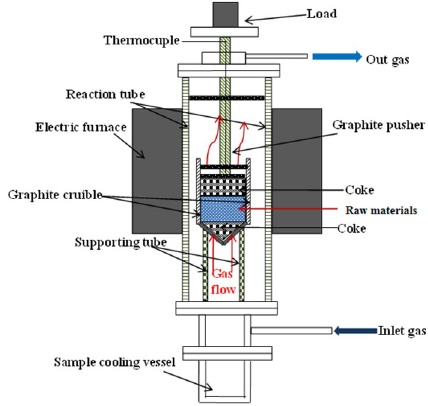
Figure 2. Experimental device for testing the melting property of iron-bearing materials.